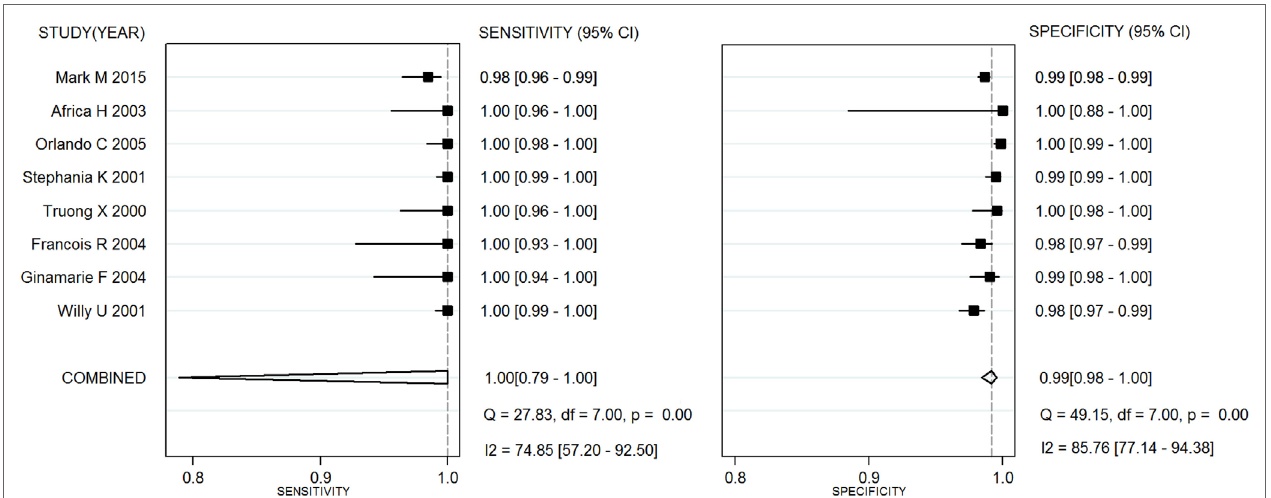
FigURe 3 | Forest plots for rapid test assay Determine HIV-1/2 ®